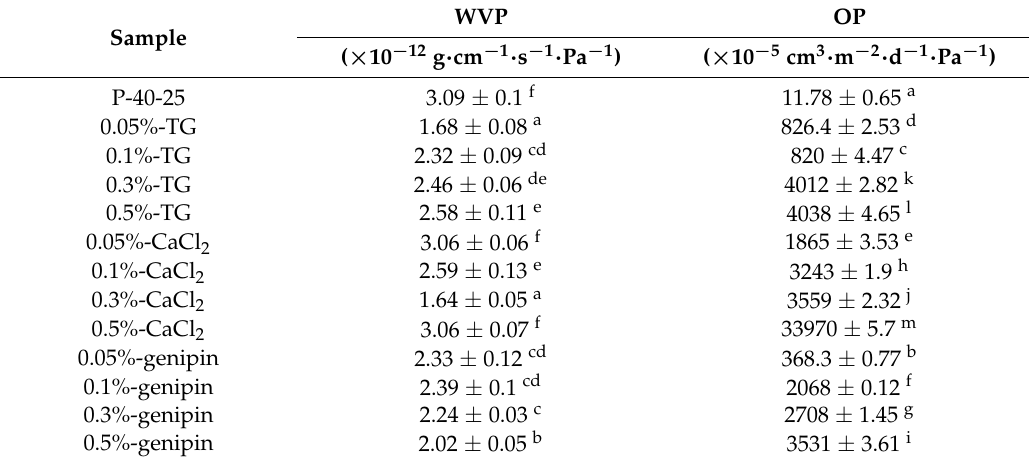
Table 3. Water vapor permeability (WVP) and oxygen permeability (OP) values for the blend films.